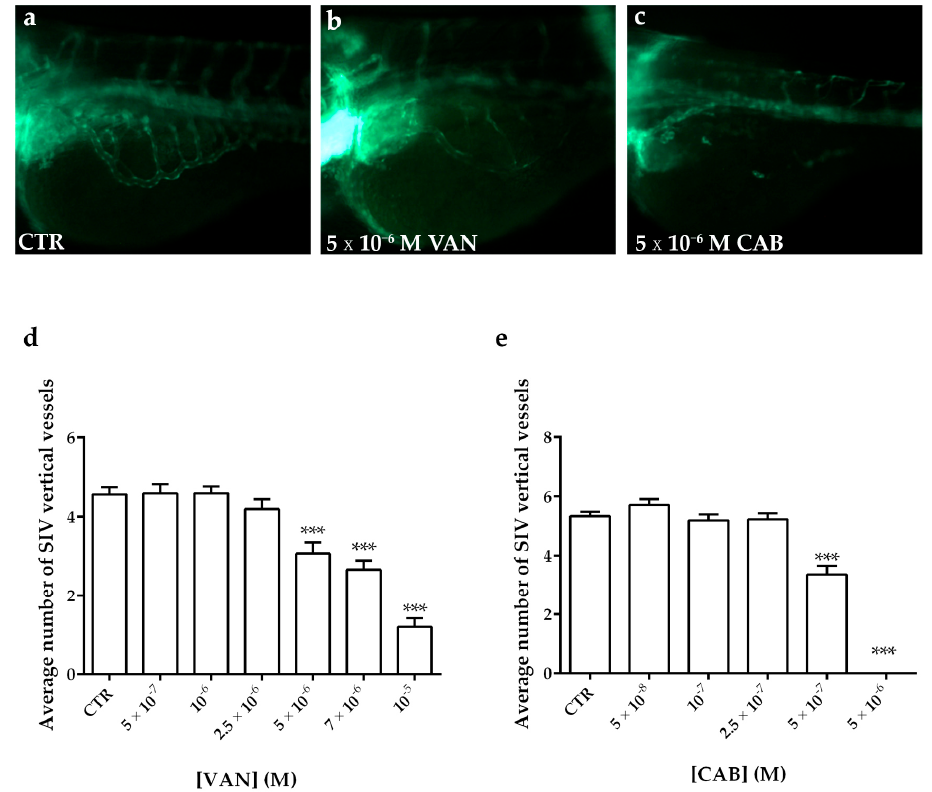
Figure 4. Anti-angiogenic effect of vandetanib (VAN) and cabozantinib (CAB) on the physiological development of the zebrafish sub-intestinal vein (SIV) plexus. Representative fluorescence images of the SIV basket of 72 hpf Tg(fli1a:EGFP) y1 zebrafish embryos treated for 24 h with dimethyl sulfoxide (DMSO) ( a ), 5 × 10 − 6 M VAN ( b ) and CAB ( c ). Following 24 h of VAN ( d ) and CAB ( e ) treatments at different concentrations, the number of vertical vessels comprising the SIV basket was counted and compared with that of the control (CTR) embryos. Graphed values represent the mean ± S.E.M. *** p < 0.001 versus the CTR. Embryos are shown anterior to the left.